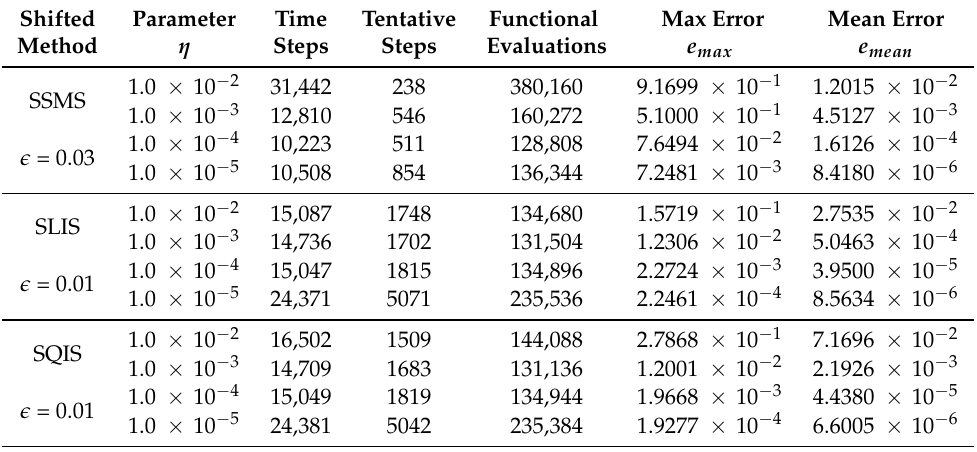
Table 15. Results of the shifted Strang–Marchuk’s splitting (SSMS), the shifted linear iterative splitting (SLIS), and the shifted quasilinear iterative splitting (SQIS) for the asymptotic case of the NLD equation. Shifted Parameter Time Tentative Functional Max Error Mean Error Method η Steps Steps Evaluations e